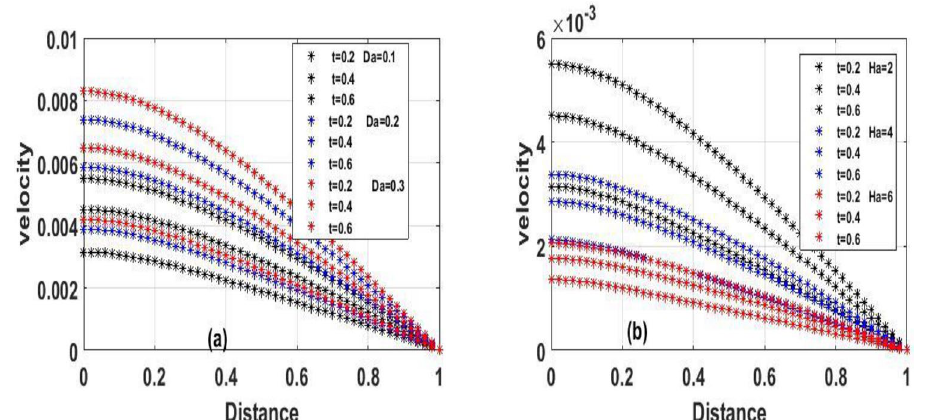
Figure 5. The effect of variation of Da and Ha for velocity unsteady state.